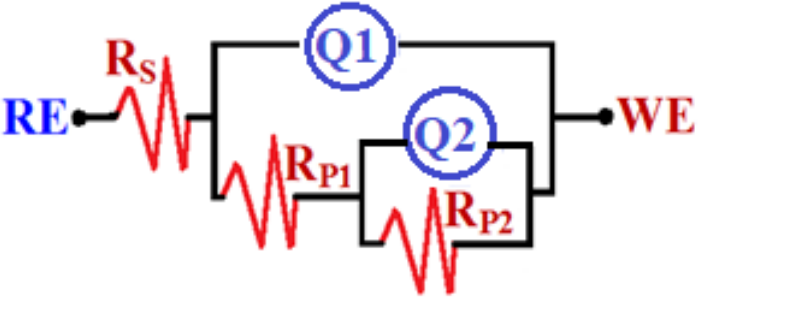
Figure 10. Equivalent circuit model. Table 3. Date recorded from fitting the data presented in Figure 8 and Figure 9.